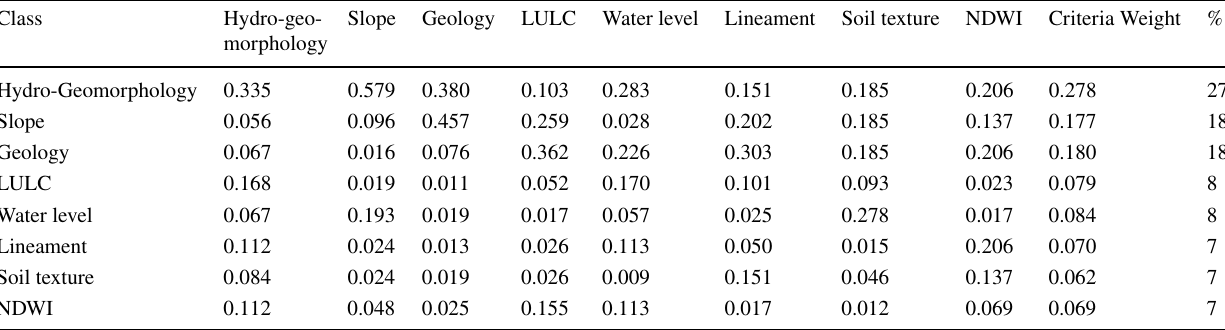
Table 2 Normalized Pairwise Comparison Matrix of Eight Variables